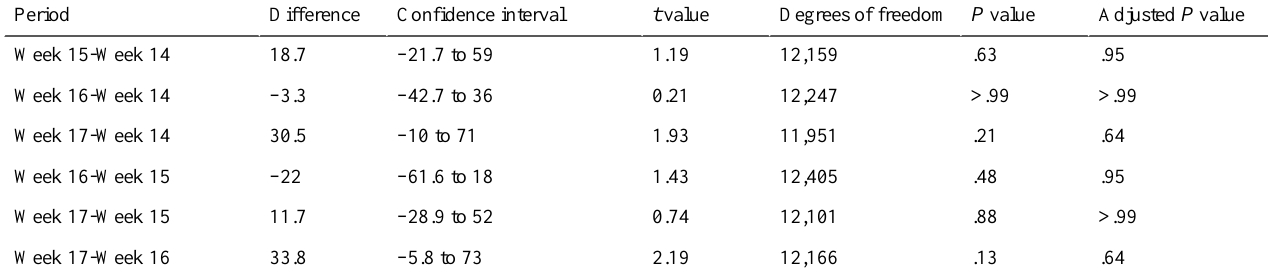
Table 2. Statistical comparisons between weeks in the Active COVID-19